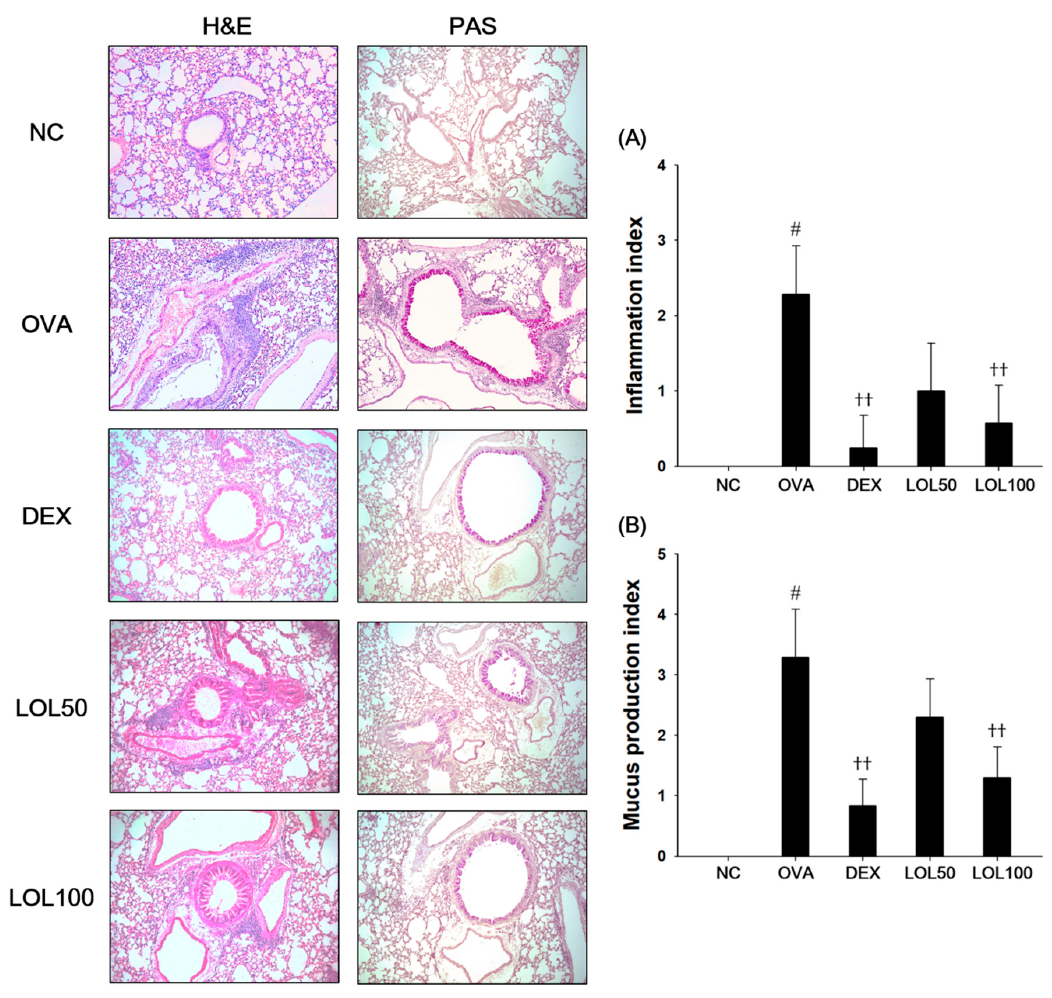
Figure 4. Effects of LOL on airway inflammation and mucus production in OVA-challenged asthma model. Histopathological analysis on ( A ) airway inflammation and ( B ) mucus production was performed in the lung tissues by hematoxylin and eosin (H&E, left panel) and Periodic acid-Schiff (PAS, right panel) staining. NC: normal control mice; OVA: OVA-challenged asthma mice; DEX: dexamethasone (3 mg/kg) + OVA-challenged asthma mice; LOL: LOL (50 or 100 mg/kg) + OVA-challenged asthma mice. The values are averaged pathologic scores of inflammatory cell infiltration and mucus production. The values expressed as the means ± SD ( n = 7/group). # p < 0.01, significantly different from NC group; †† p < 0.01, significantly different from OVA-challenged group.